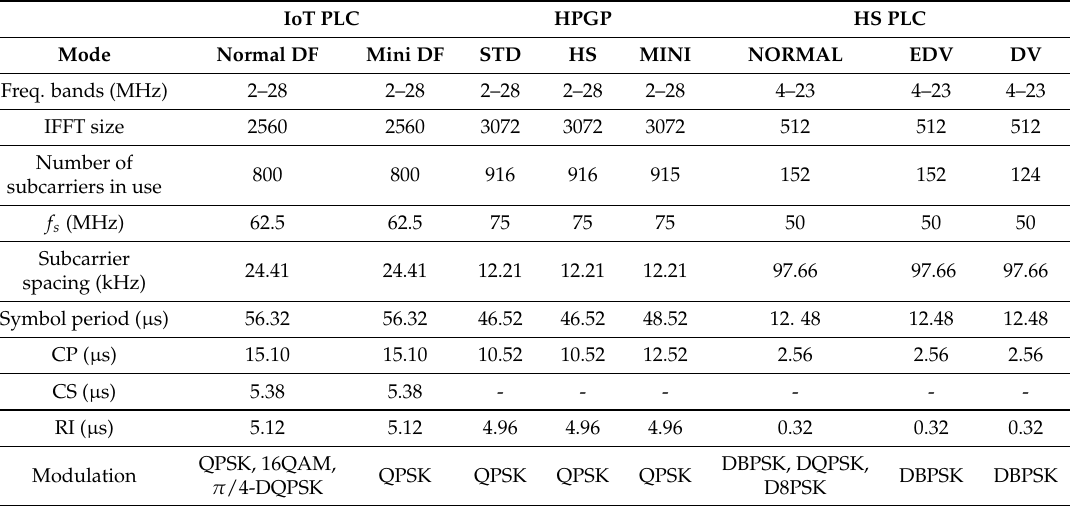
Table 2. Channel and OFDM